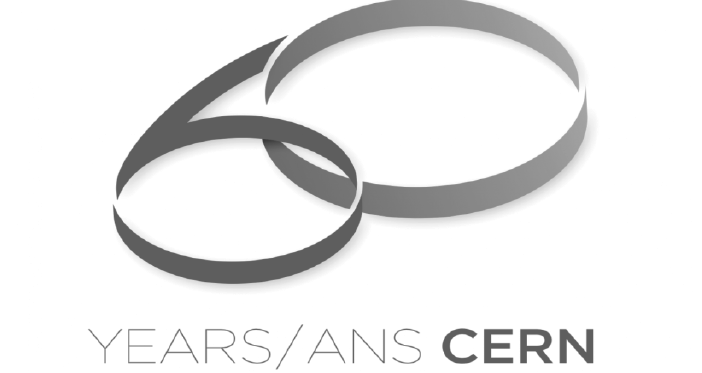
Fig. 15. CERN 60th Anniversary Emblem and Logotype. g y